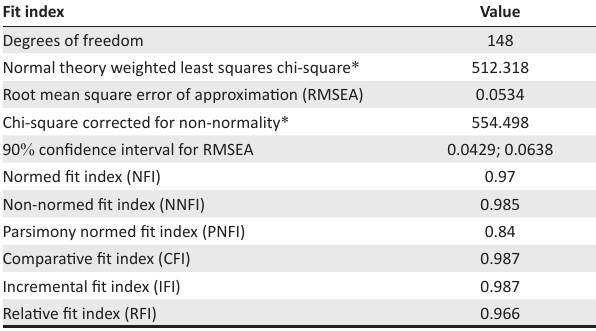
TABLE 3: Summary of goodness-of-fit